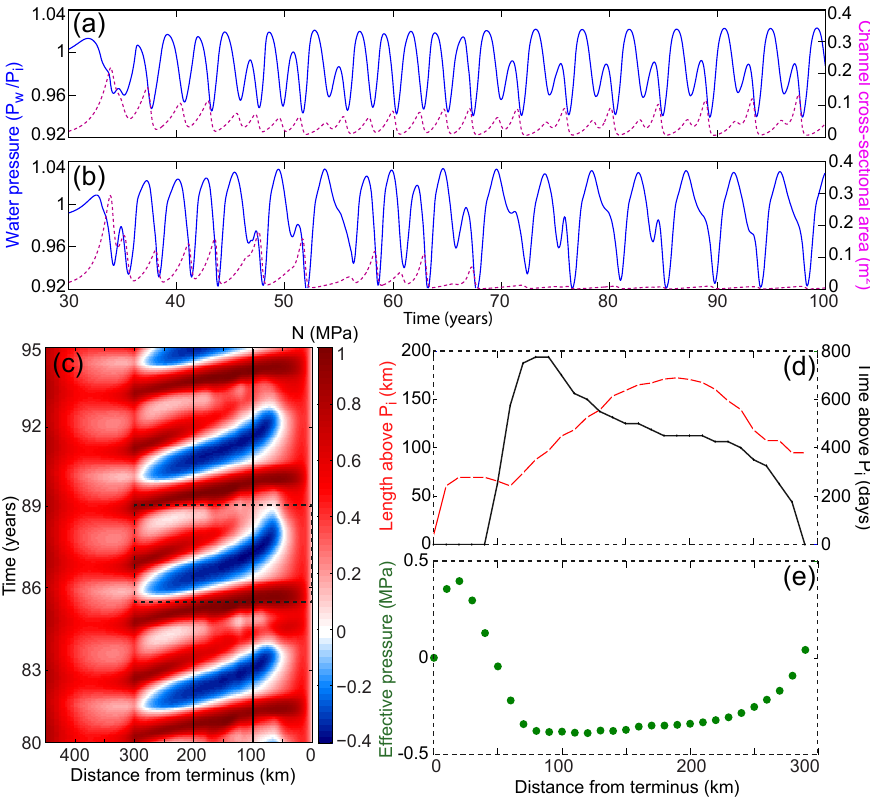
Figure 3. Model outputs from the system with no overdeepening. (a, b) Average water pressure (blue) and channel cross-sectional area (purple dashed) across the ice stream at a distance of 200 and 100km from the front, respectively, corresponding to the solid black lines in (c) . Prior to 30 years no pressure waves occur and so that time period is not plotted. (c) Time–distance plot of center line effective pressure demonstrating several pressure waves. The dashed box shows the feature analyzed in (d) and (e) . (d) Longitudinal length affected by negative effective pressures at the time of pressure wave passing (red dashed curve) and the time of an area below negative effective pressure (black curve) along the ice stream. (e) Minimum effective pressure (green) along the ice